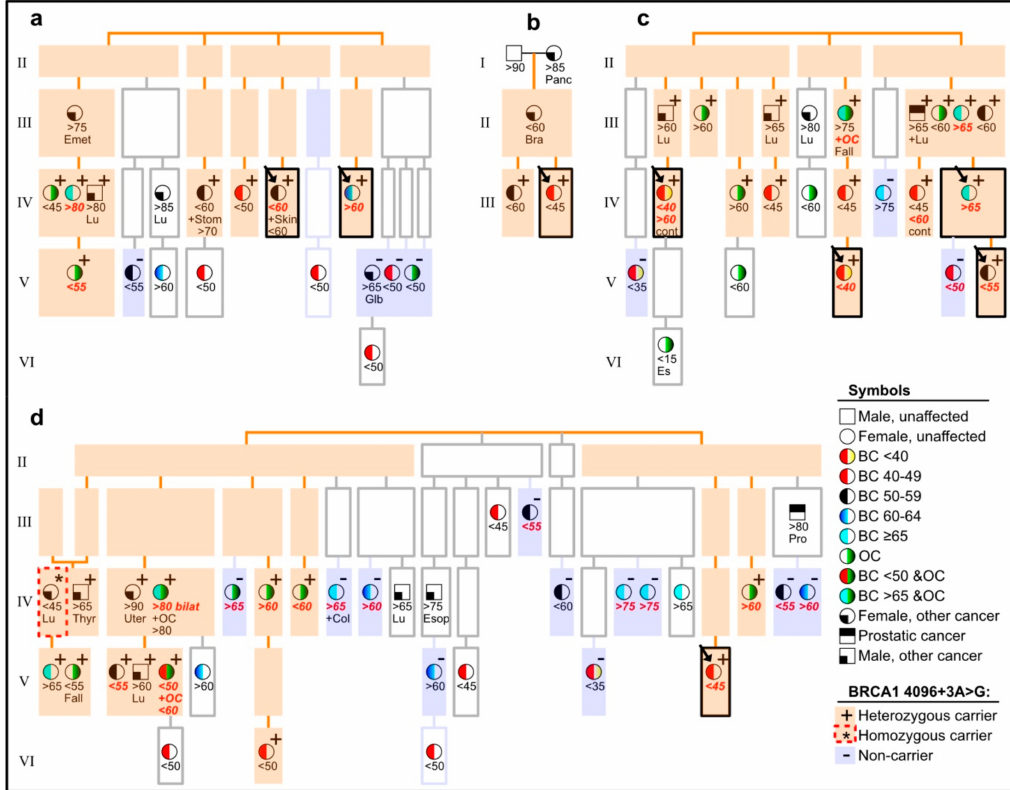
Figure 2. Pedigrees ( a – d ) of eight probands (arrows in boxes with black borders), showing cancer-affected individuals and their carrier status, with regard to the BRCA1 c.4096 + 3A > G variant, but withholding details on other pedigree members and exact pedigree structures, in order to avoid recognition. Light orange background is used to highlight segregation of the variant, and light violet background highlights cancer-affected non-carriers. Individuals with a white background were not available for genotyping. See explanation of symbols in the lower right corner of the figure (BC = breast cancer, OC = ovarian cancer). Information about approximate age (in years) at diagnosis of cancer is shown below symbols, in accordance with the symbol’s indication of cancer type, plus further details, in case of contralateral breast cancer (cont), fallopian tubes (Fall), endodermal sinus (Es) or cancers other than BC or OC (Bra for brain, Col for colorectal, Emet for endometrial, Esop for esophageal, Glb for gallbladder, Lu for lung, Pro for prostatic, Stom for stomach, Thyr for thyroid, Uter for uterine). Letters in bold red italic denote that the tumor in question was included in analyses of LOH (loss of heterozygosity) and / or